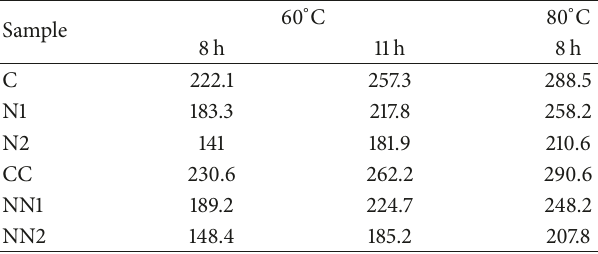
Table 4: Accumulative hydration heats of the plain cement and the binders containing phosphorus slag (J ⋅ g −1 ).